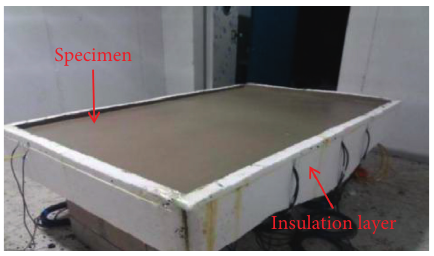
Figure 1: Specimen